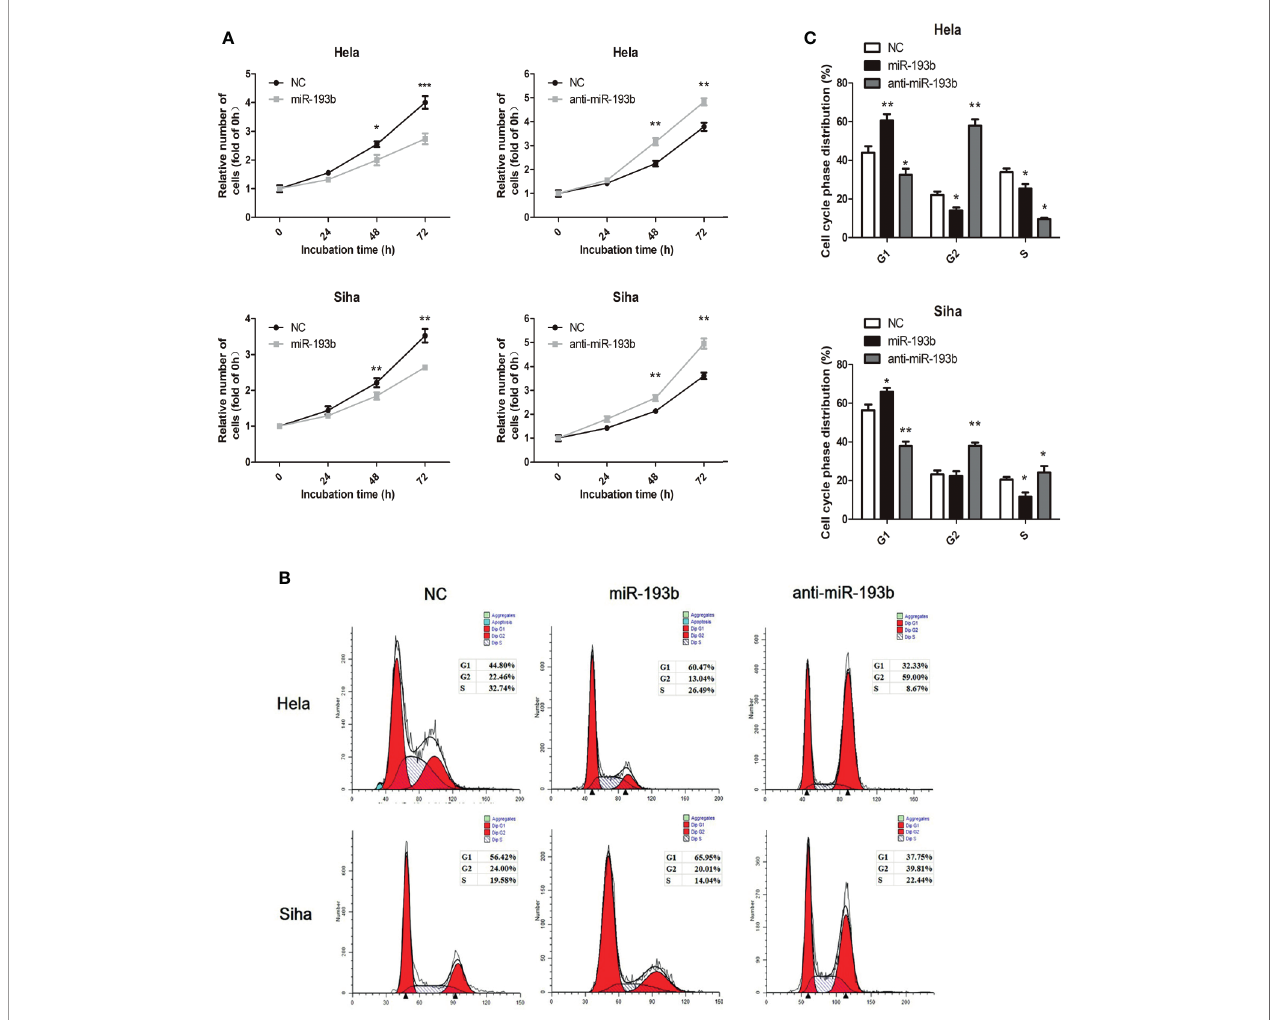
FIGURE 1 | miR-193b is a tumor suppressor in cervical cancer. Either miR-193b or anti-miR-193b was used to transfect Hela and Siha cells as described. (A) CCK-8 assays were carried out to determine cellular proliferation. (B) Flow cytometry was used to assess distributions of cells across the cell cycle. (C) The quali fi cations of the cell cycle were presented. * p < 0.05, ** p < 0.01, *** p <